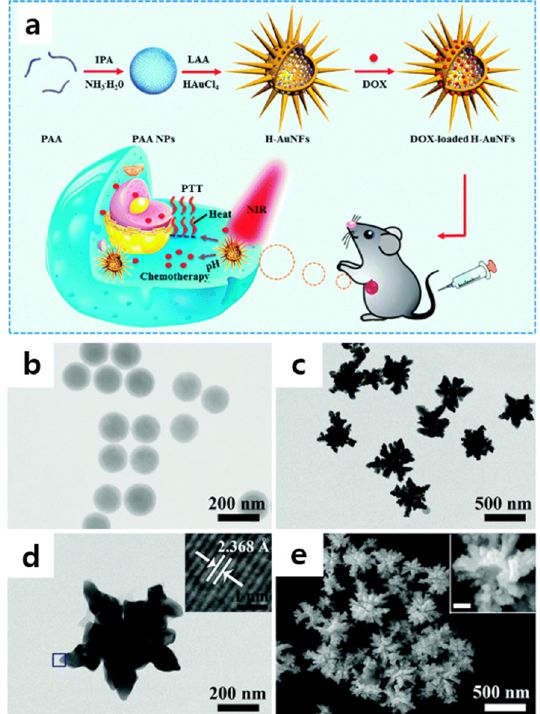
Figure 2. ( a ) Schematic of the synthetic strategy for H–AuNFs as pH/near-infrared (NIR) dual-responsive drug vehicles for in vitro and in vivo synergistic chemo-photothermal cancer therapy. IPA = isopropyl alcohol, LAA = L -ascorbic acid, DOX = doxorubicin hydrochloride. Transmission electron microscopy (TEM) images of ( b ) polyacrylic acid nanospheres and ( c ) H–AuNFs. ( d ) High-resolution transmission electron microscopy (HR-TEM) image of a single H–AuNF. Inset: magnification of the area marked with a square. ( e ) Scanning electron microscopy (SEM) image of H–AuNFs. Inset: SEM image of a broken H–AuNF (scale bar: 100 nm). Reprinted with permission from Ref. [20]. Copyright 2015, The Royal Society of Chemistry.